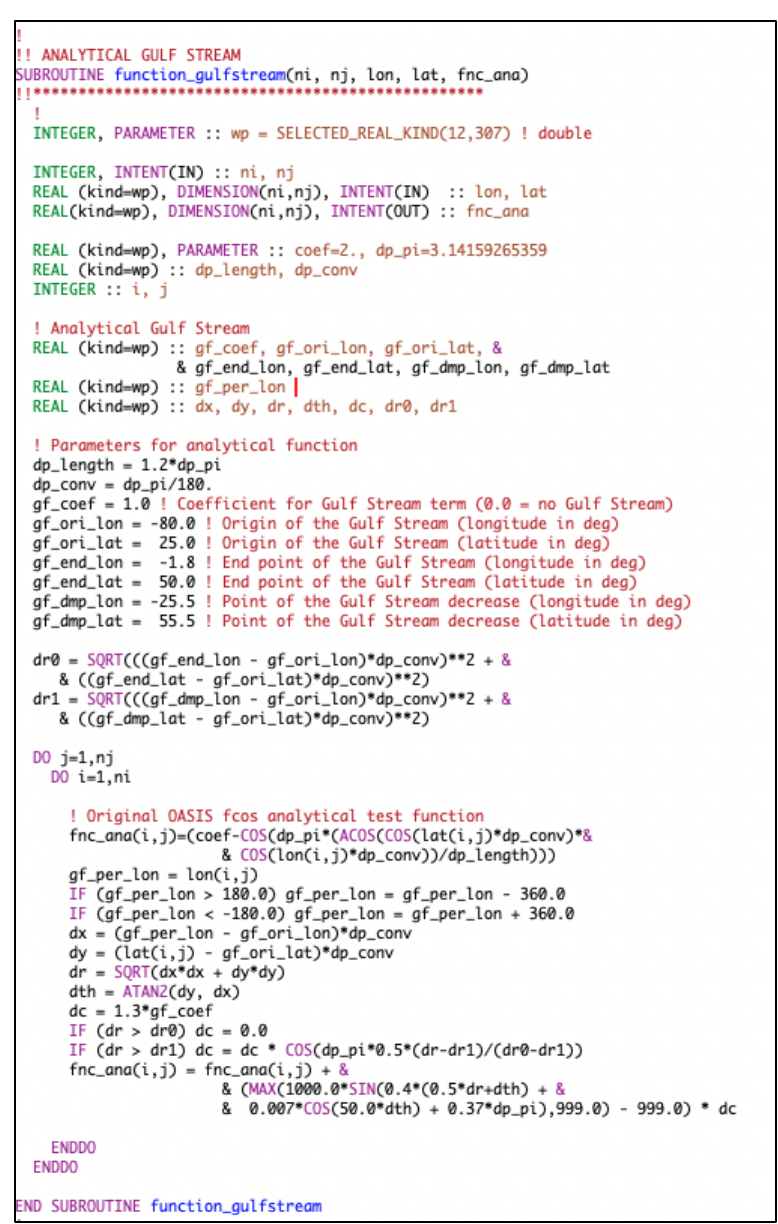
Figure A4. Fortran 90 code defining the gulfstream analytical function.